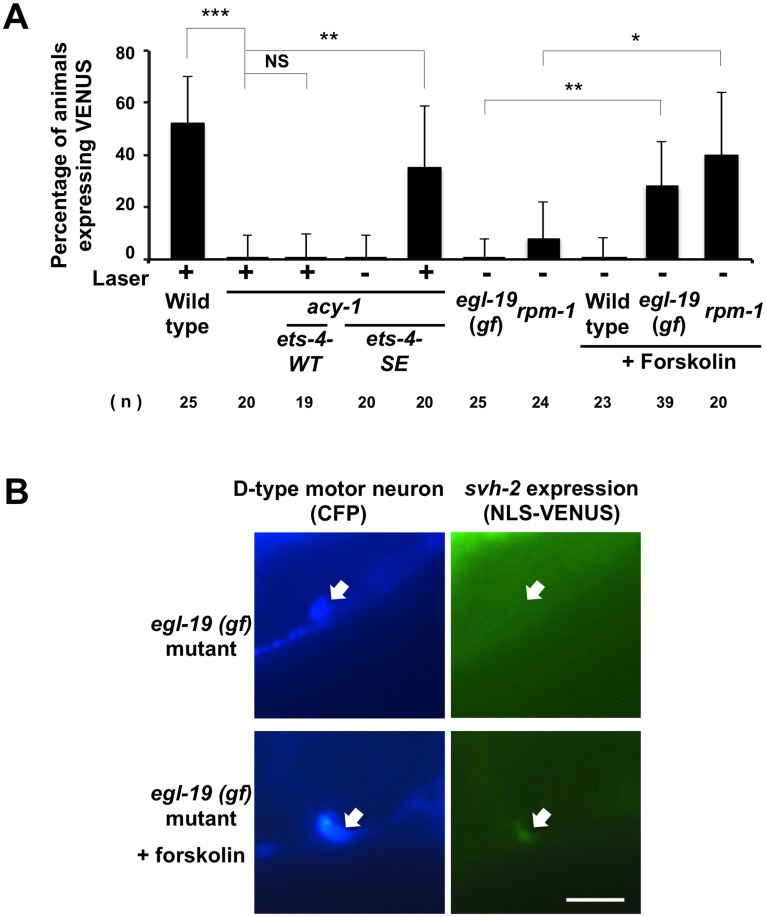
Activation of both cAMP and Ca2+–p38 MAPK signaling pathways is required for the induction of svh-2 transcription.(A) Percentages of animals expressing svh-2. Induction of Psvh-2::nls::venus expression in D-type motor neurons with (+) or without (-) laser surgery was assayed as described in Materials and Methods. The numbers (n) of animals examined are shown. Error bars indicate 95% SI. ***P<0.001; **P<0.01; *P<0.05; NS, not significant. (B) Psvh-2::nls::venus expression in D-type motor neurons. Expression of fluorescent proteins in D-type motor neurons of egl-19(gf) mutants with or without forskolin treatment are shown. Arrows indicate cell bodies of D-type neurons. D neurons are visualized by CFP under control of the unc-25 promoter. Scale bar = 10 μm.